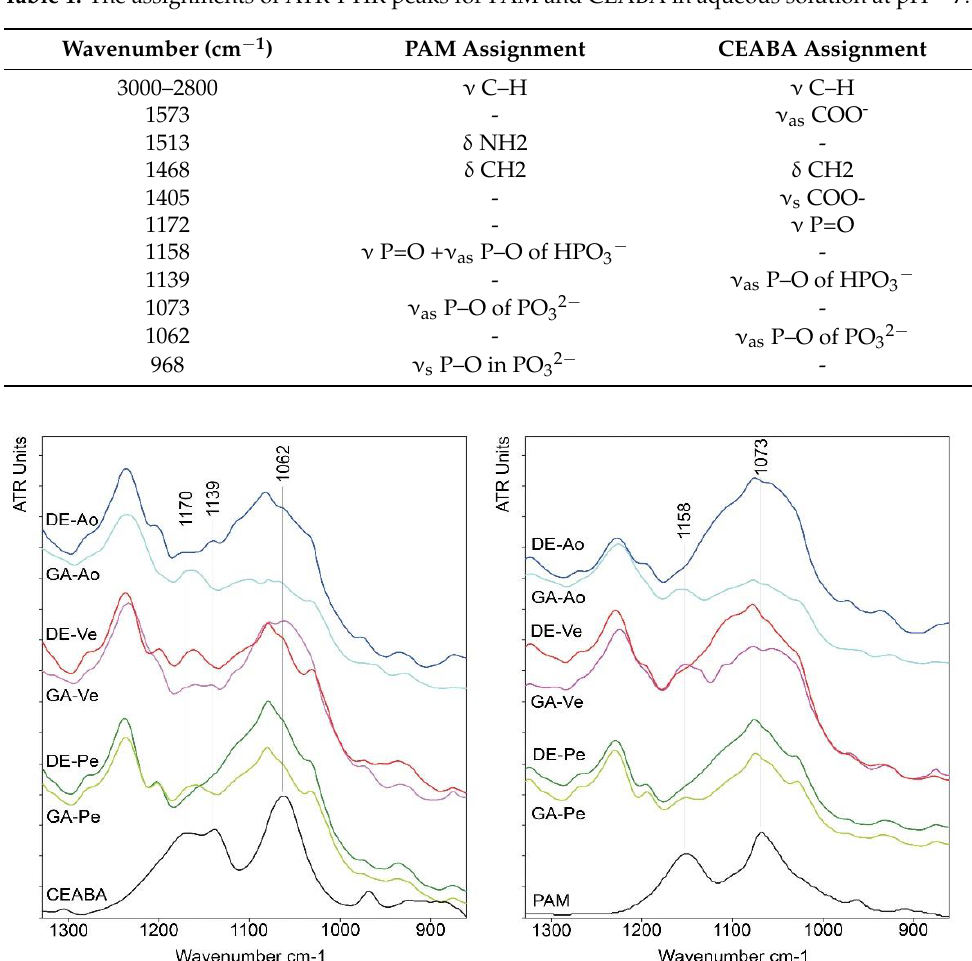
Figure 3. ATR-FTIR spectra of the BP solutions at pH 7 and of the cross-linked biomaterials treated with PAM and CEABA in the region 1340–860 cm ⁻1 .